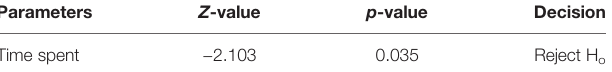
TABLE 3 | Comparison between the men and women in time spent for ornamental fi sh business and household activities. Parameters